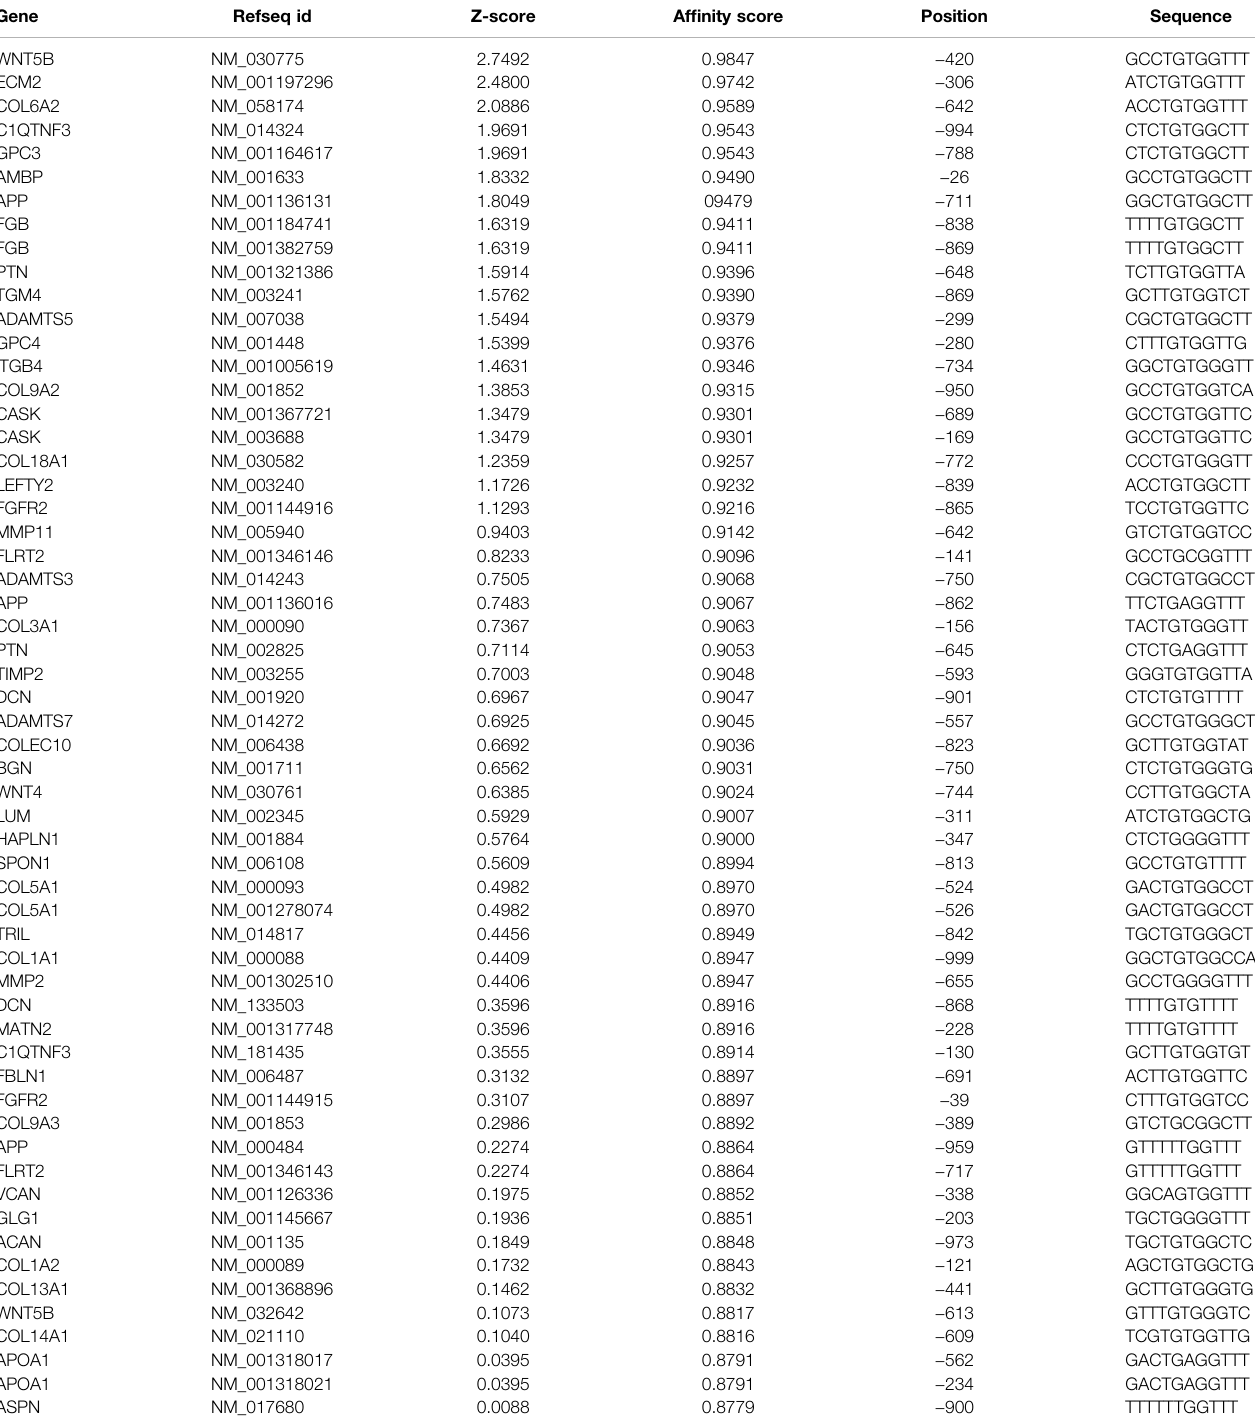
TABLE 3 | ECM genes upregulated in trisomic hearts with consensus sequence for RUNX1 matrix.